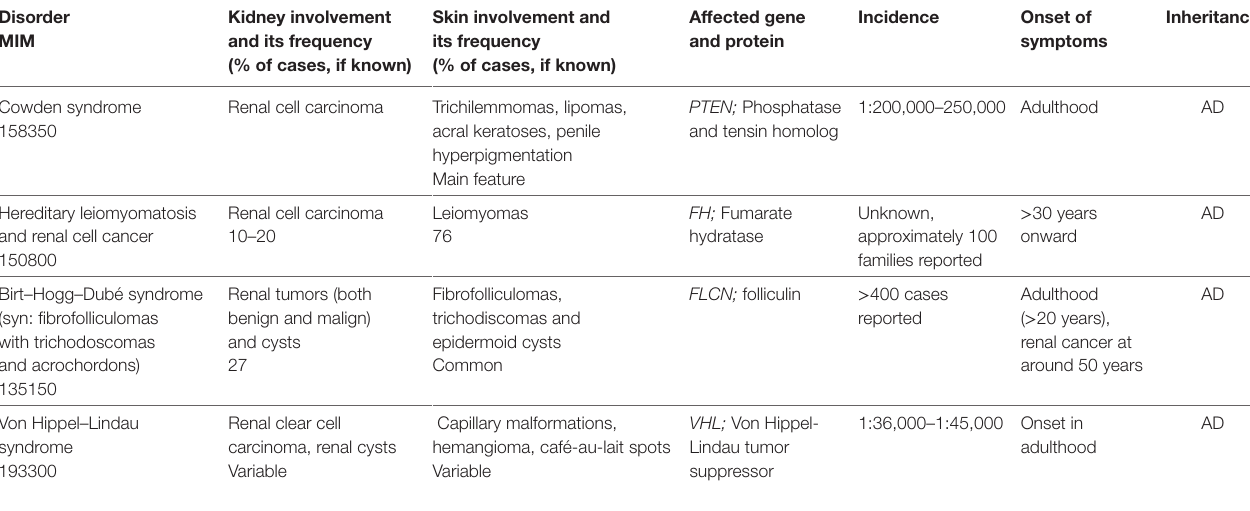
TABLe 4 | Genetic tumor predisposition syndromes with cutaneous and reno-urinary